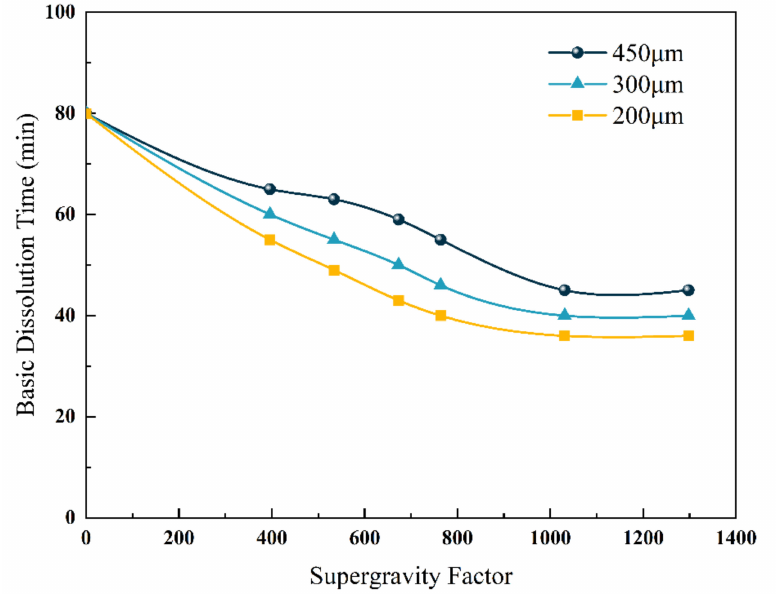
Figure 10. Variation curve of super-gravity factor versus dissolution time for different packing pore